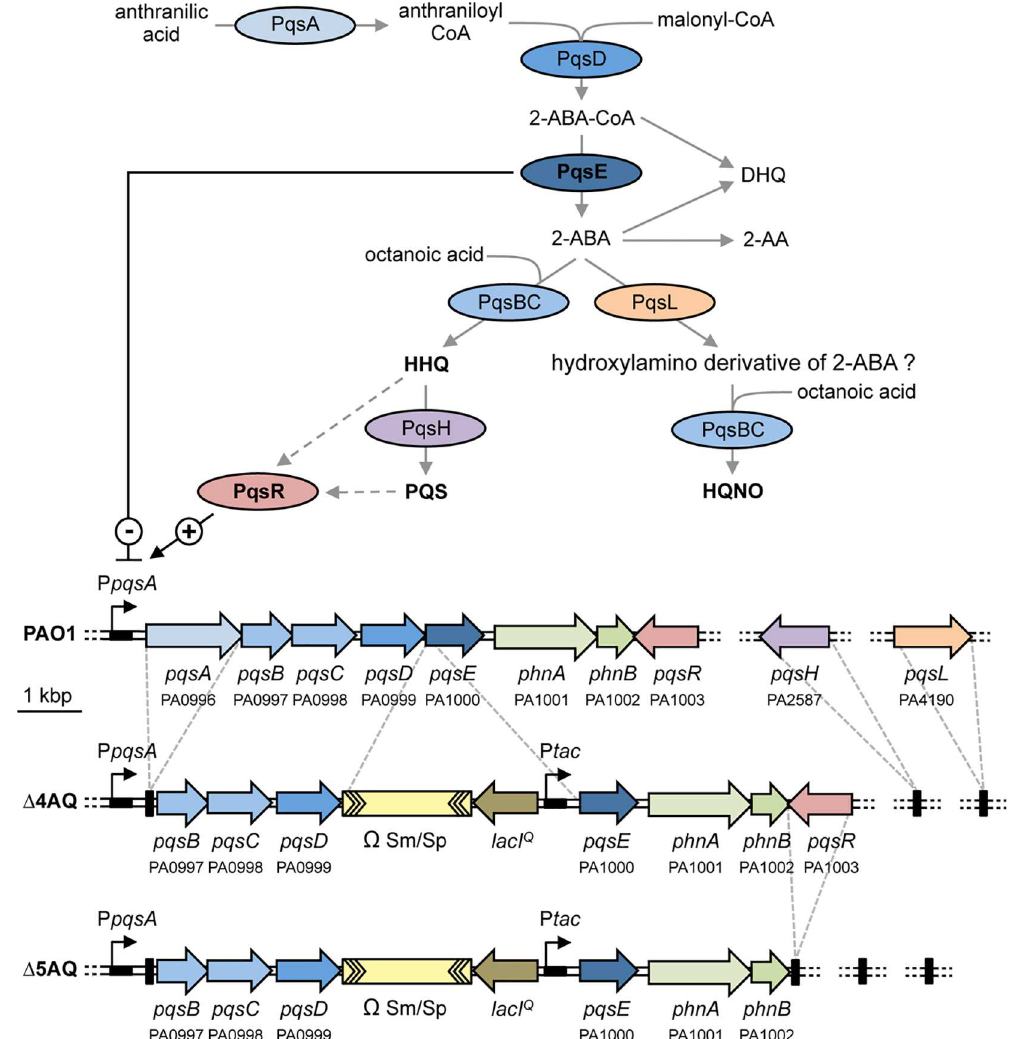
the pqs QS system (HHQ, PQS, HQNO, PqsE, and PqsR) are in bold face. The PA number is indicatedbelow the genes accordingto the Pseudomonas Genome Database[13]. Solid grey arrows represent biosynthesis; dashed grey arrows represent informationflow; solid black arrow indicates activation (+); black T-line indicates negative